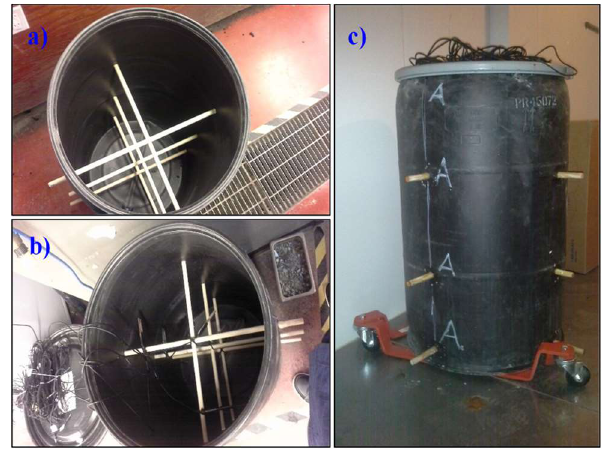
Figure 2. Instrumented barrel with RT-1 sensors before ( a , b ) and during testing ( c ).